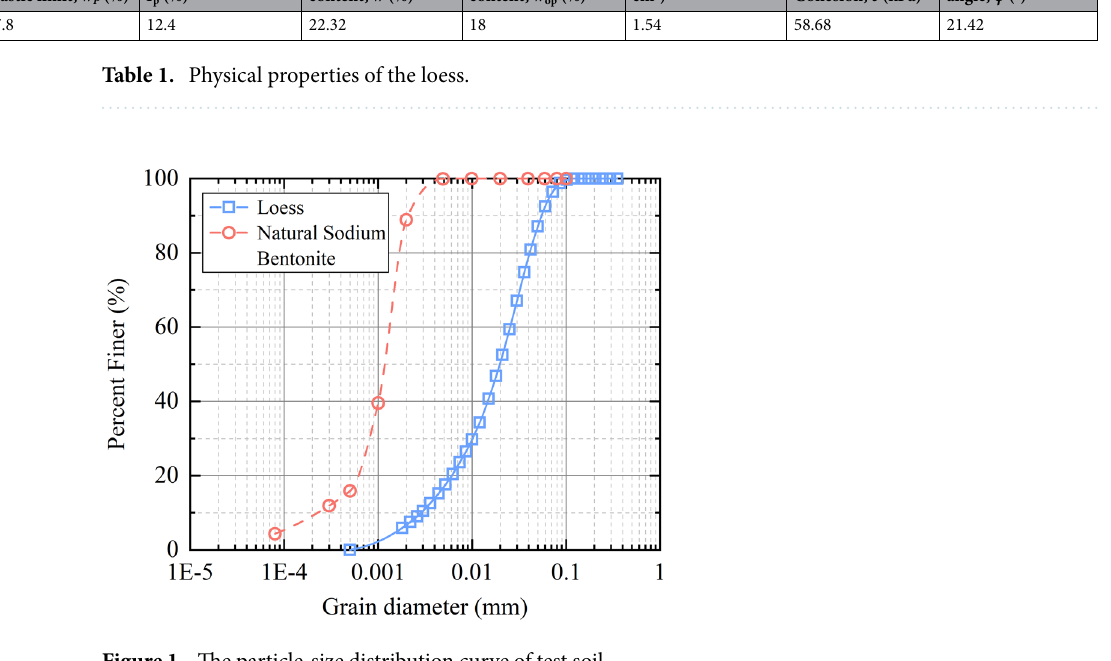
Figure 1. The particle-size distribution curve of test